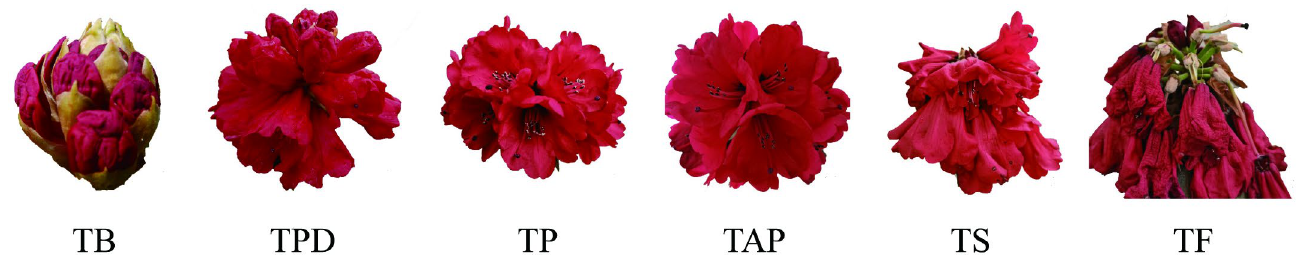
Figure 1. The phenotype of samples in each period. TB: the time of bud stage; TPD: pollen dehiscence stage; TP: pollination stage; TAP: after pollination stage; TS: senescence stage; and TF: fading stage.